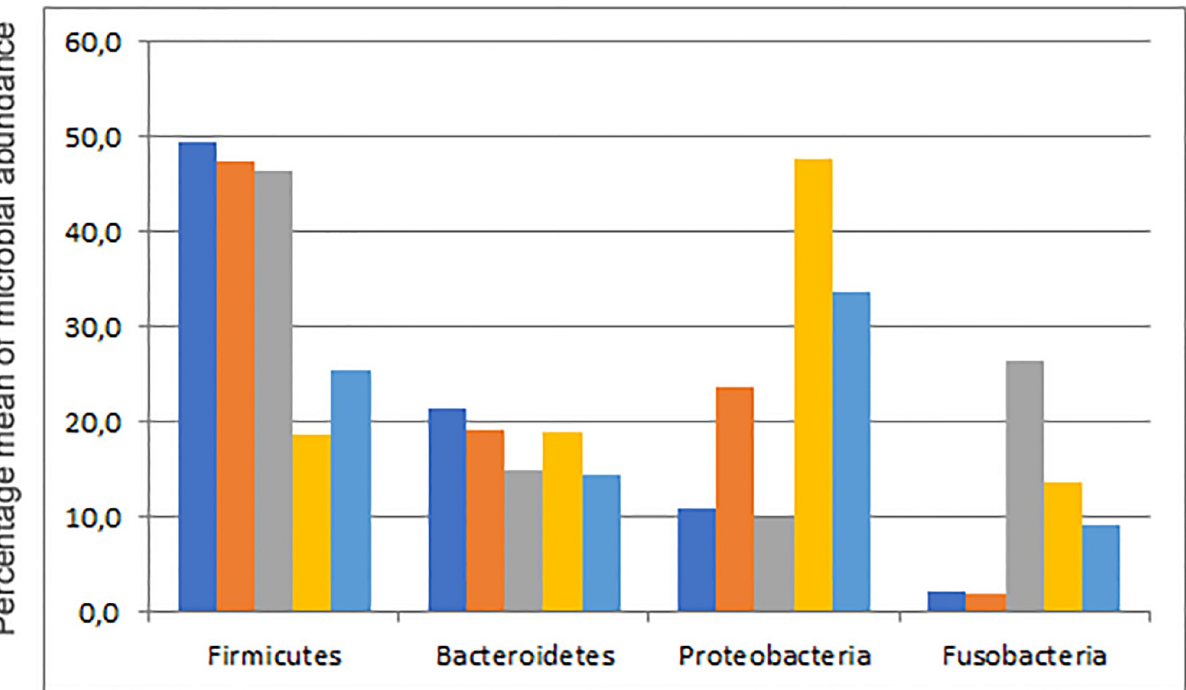
Fig 4. Percentage mean of abundance of main microbial components found in different studies on sea turtles. Samples are indicated as follows: blue: this study; red: Abdelrhman et al . [23]; grey: Biagi et al . [24]; yellow: Ahansan et al . [26]; light blue: Ahansan et al . [27].